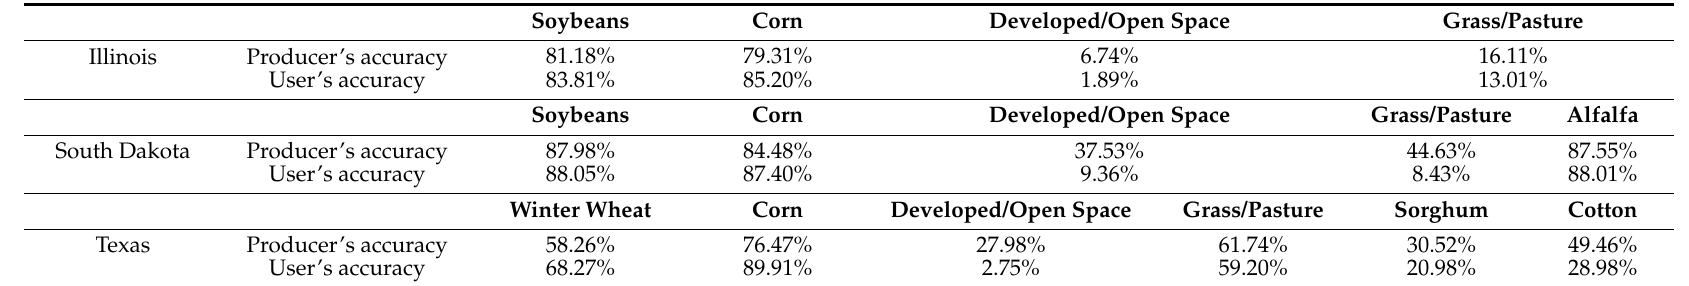
Table 3. Mean producer and user accuracies of classification based on TI + RF method.